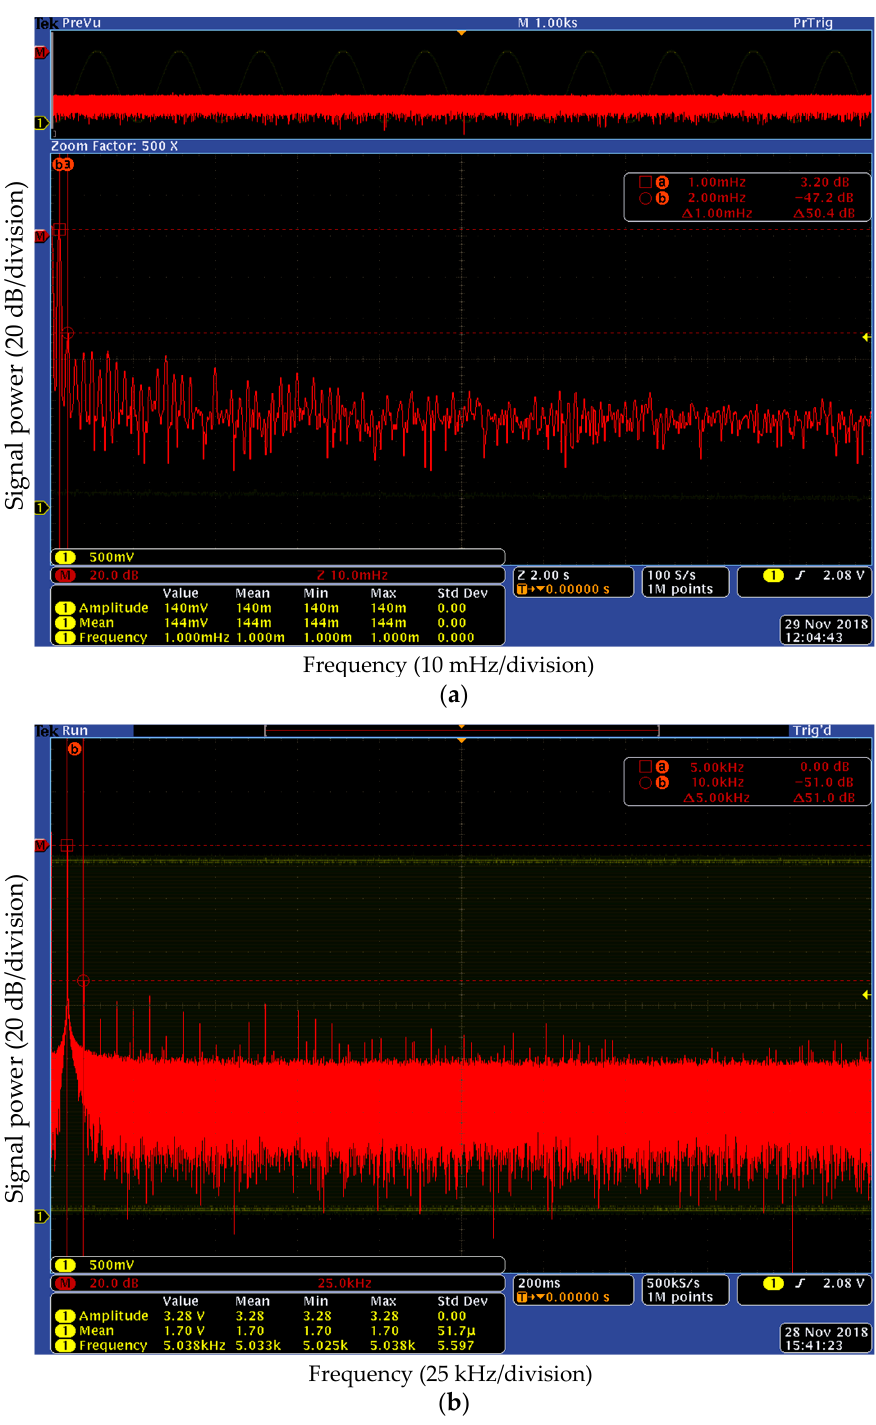
Figure 8. Spectrum (signal power in dB versus frequency) of the sine signals shown in Figure 7: ( a ) 1 mHz and ( b ) 5 kHz.